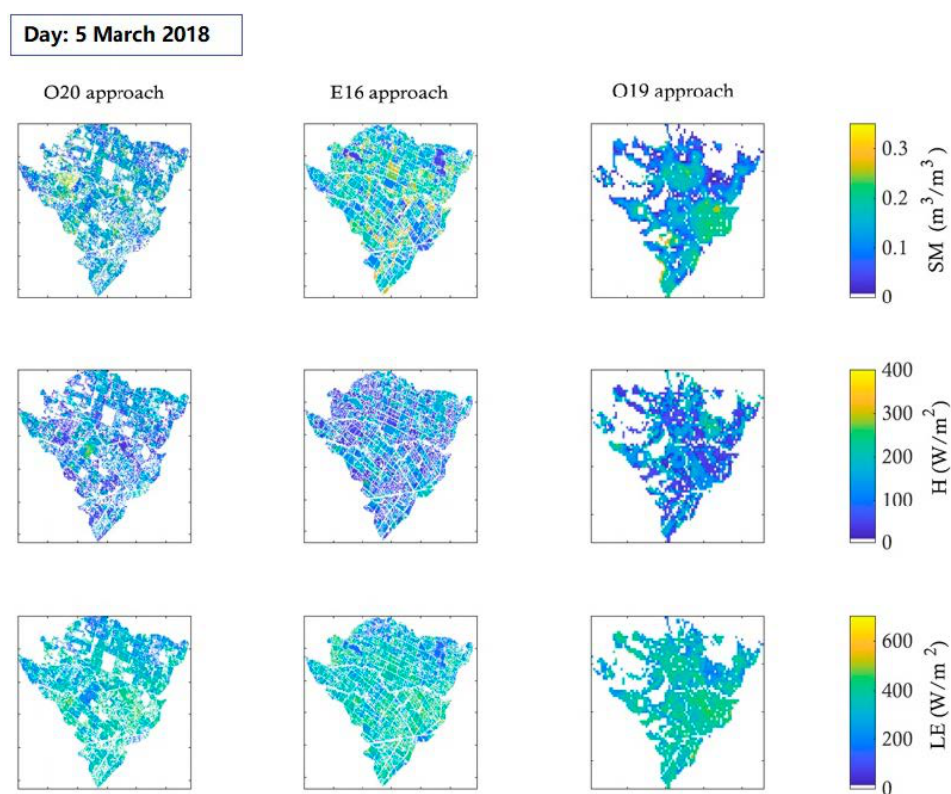
Figure 11. Same as Figure 9, but for 3 May 2018.